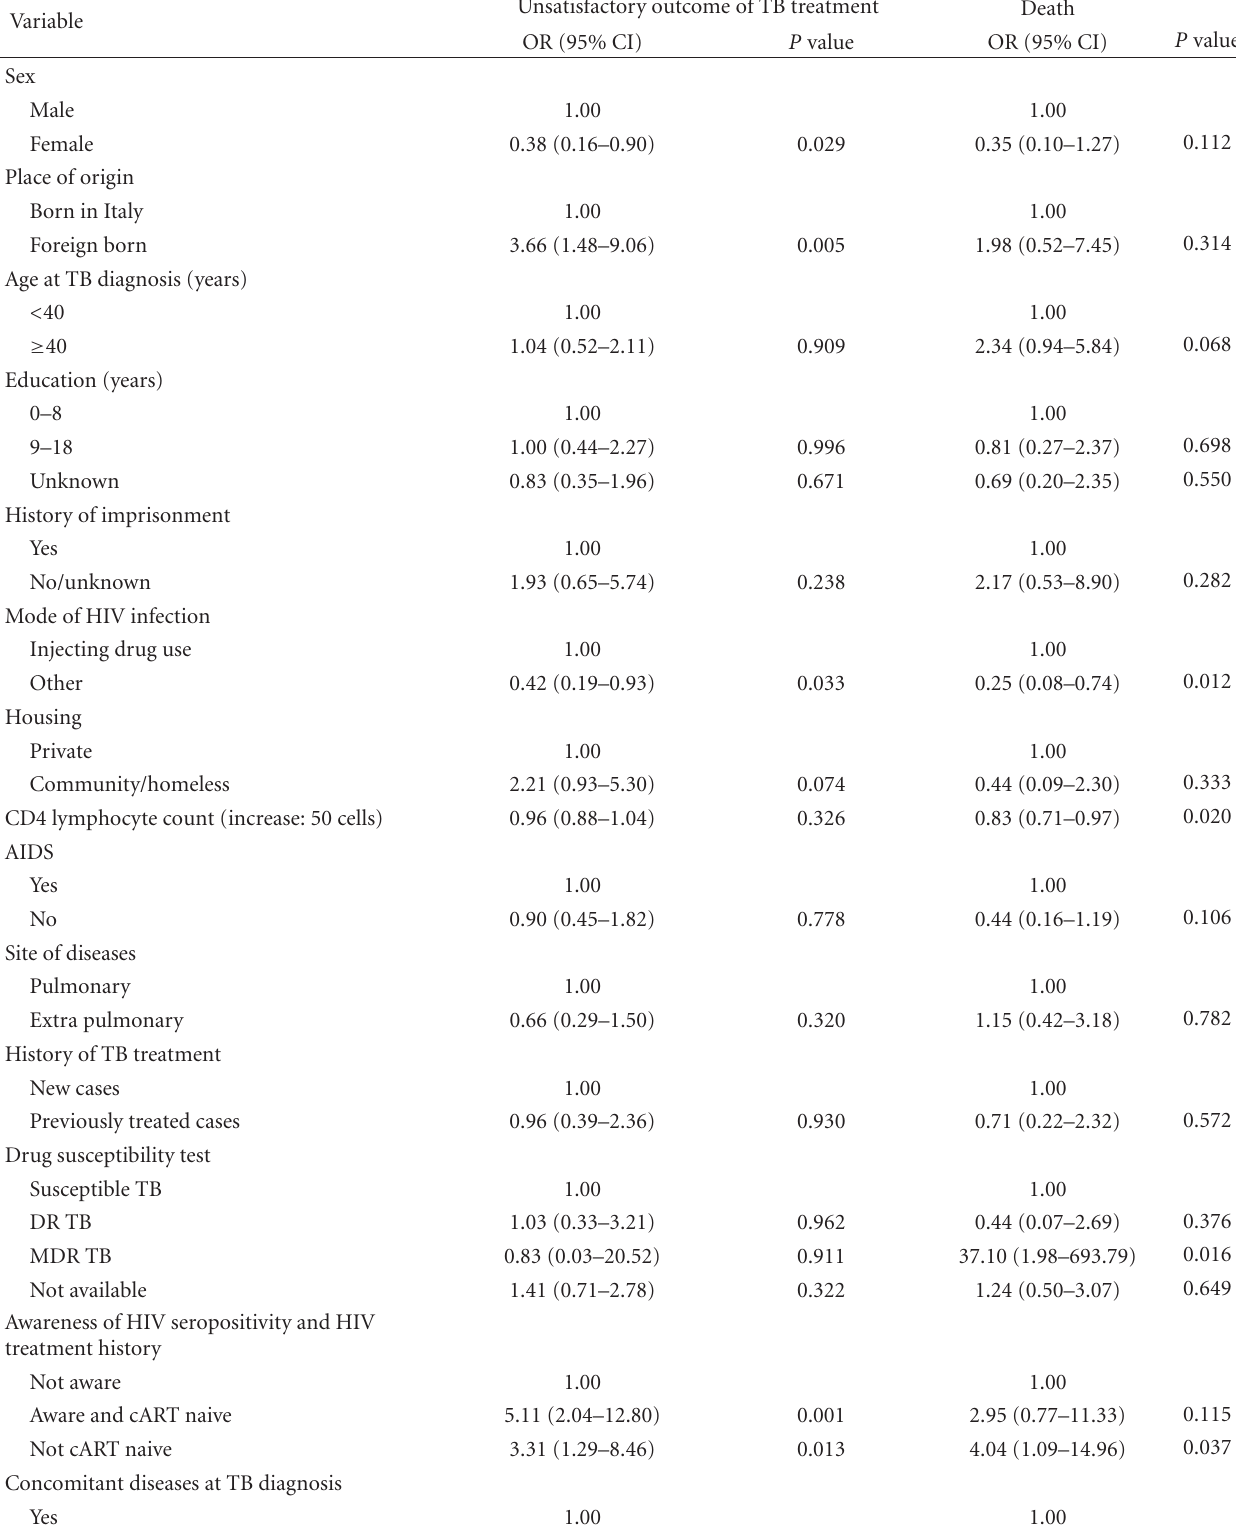
Table 2: Multivariable odds ratios ∗ of unsuccessful outcome of tuberculosis treatment and death according to baseline characteristics for 246 HIV-infected patients with